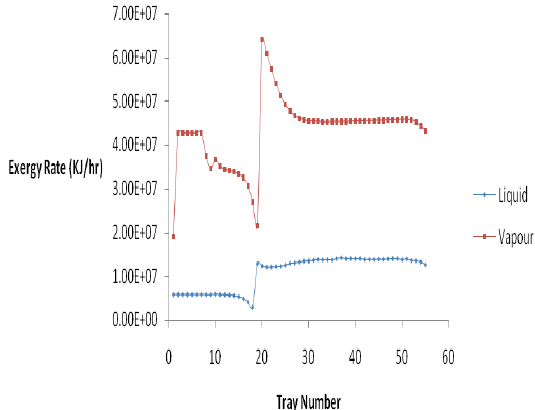
Figure 24. Profile of exergy rate versus tray number for Depropanizer of base case, Reflux Ratio 6